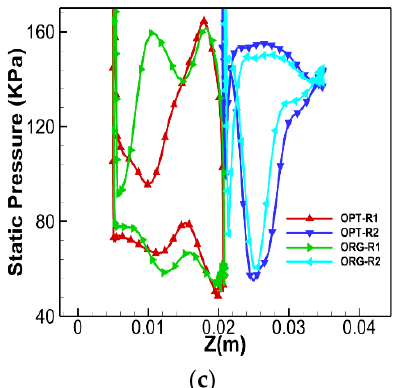
Figure 14. The static pressure distribution on the surface of the original and optimized tandem rotor. ( a ) 10% span; ( b ) 50% span; ( c ) 90%